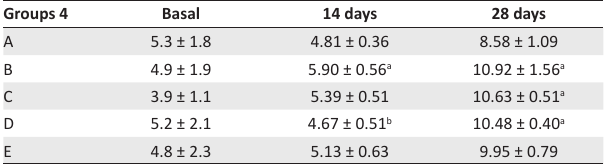
TABLE 6: Effects of Vernonia amygdalina on white blood cell count (10 3 / µ L) of alloxan-induced diabetic rats. Groups 4